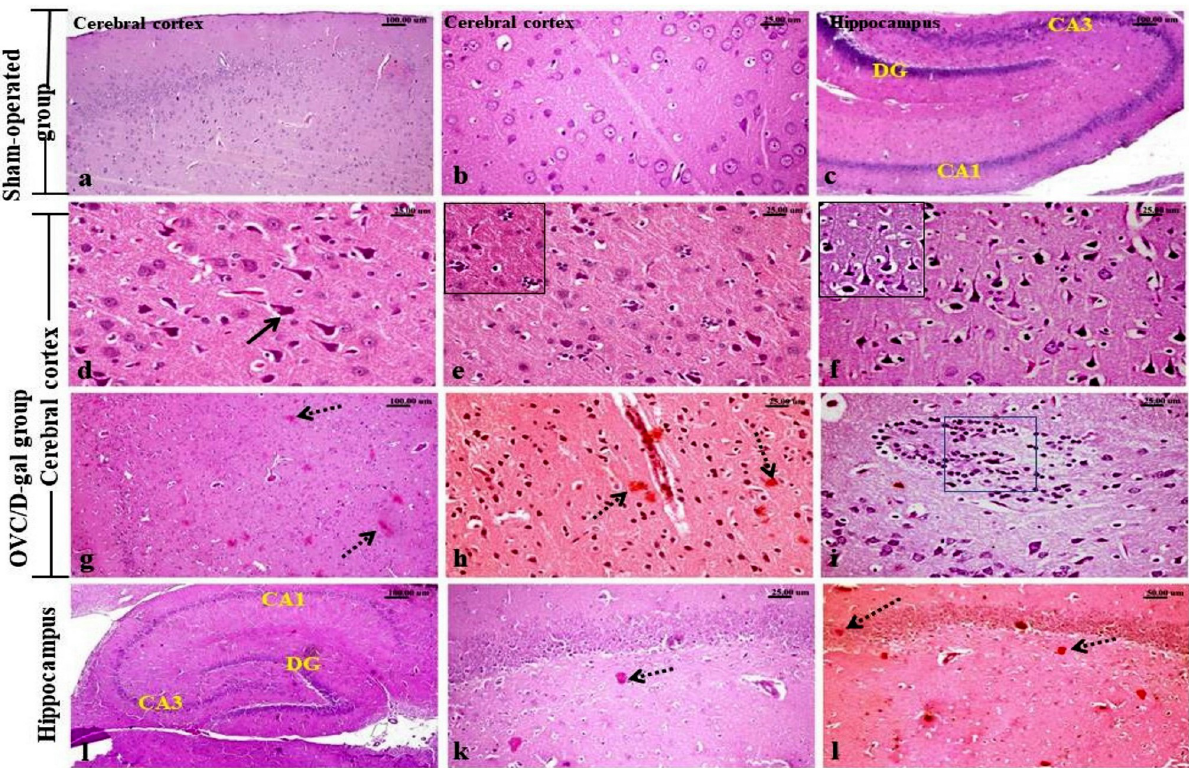
Fig 4. H&E stained photomicrographs of frontal cortex and hippocampus, (a-c) Sham-operated group, showing normal histological structure. (d-l) OVC/D-gal group, showing; (d) neuronal cells degenerative changes as shrunken neurons with accentuated dusky cytoplasm, vacuolar degeneration (e) marked neuronophagia (upper corner) with scattered apoptosis, (f) corkscrew appearance of the neuronal apical dendrites (g) variable sizes amyloid plaques (dotted-arrow) which (h) stained positively with Congo red stain, (i) glial nodules with satellatosis around degenerated neuron. (j-l) dorsal hippocampus showing vacuolation and loss of the small pyramidal cells of the dentate gyrus (DG) with degenerated cells in the granular layer as well as in Cornu Ammonis (CA) 1 and 3 subdivisions with (k) different sizes amyloid plaques (dotted-arrow) which (l) stained positively with Congo red stain.